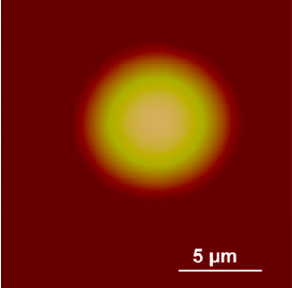
Figure 14. The image of the microlens scanned by AFM.